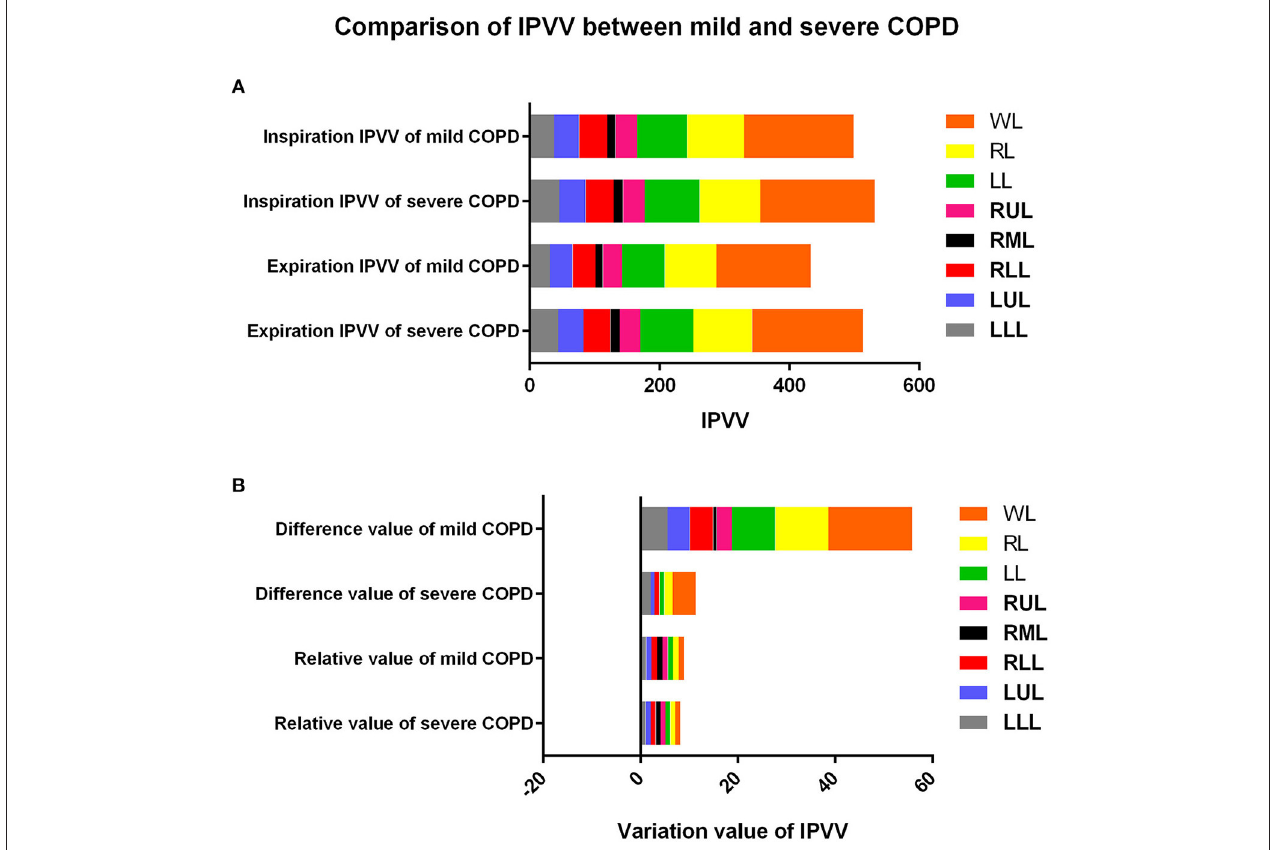
FIGURE 3 | Comparison of IPVV between mild and severe COPD in inspiratory, expiratory CT, difference value and relative value. (A) Comparison in inspiratory and expiratory CT; (B) Comparison in difference value and relative value.